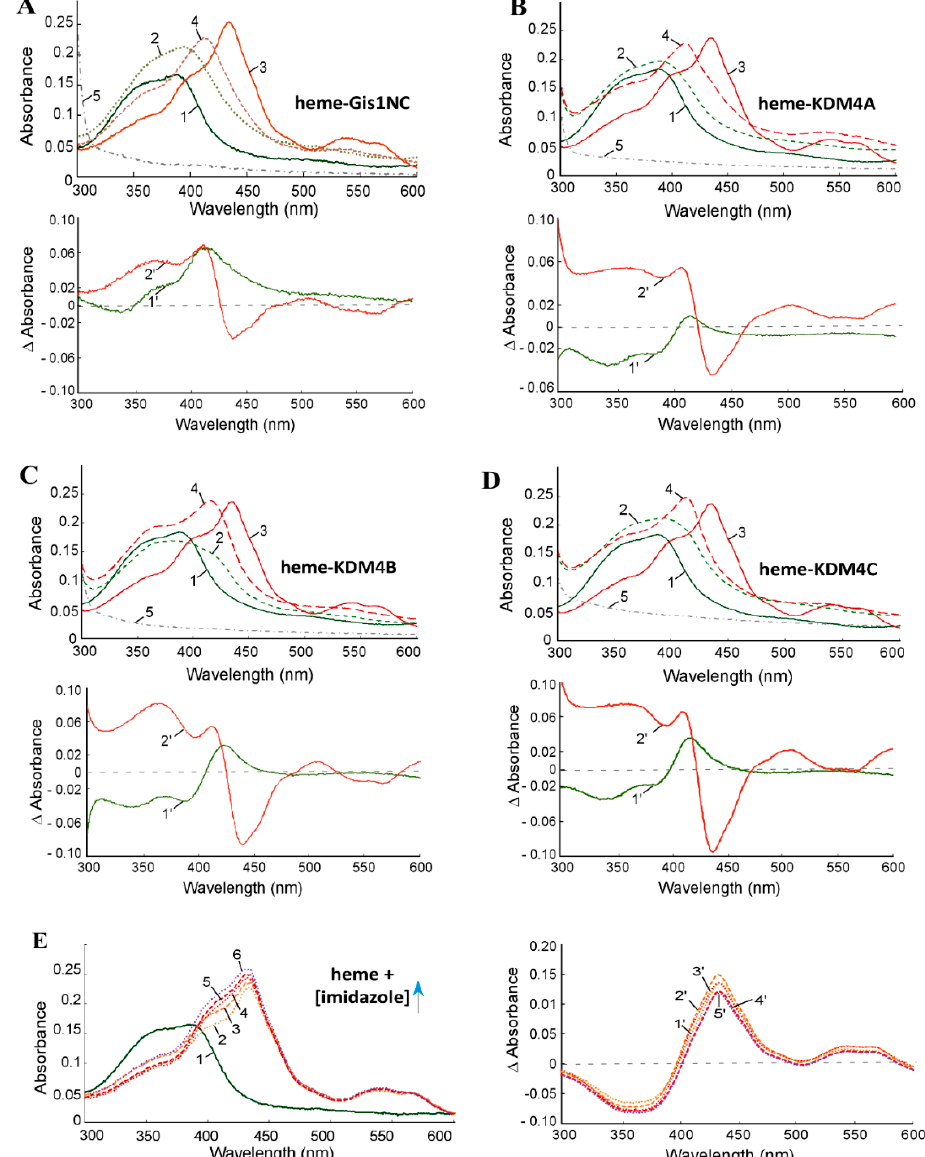
Figure 3. Absorption spectra of heme in the absence and presence of KDM4 JmjN / C domains. ( A )